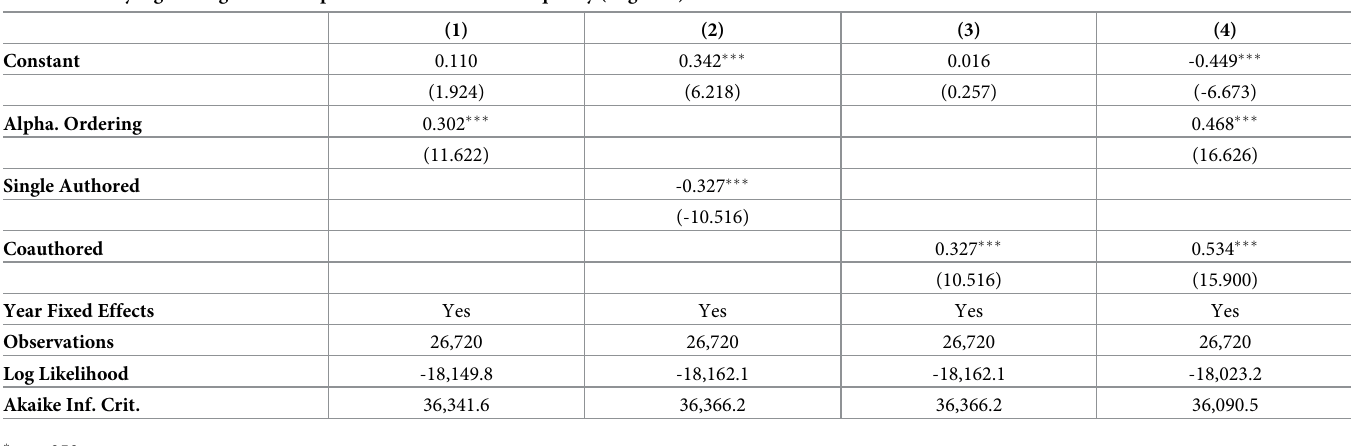
Table 5. Binary logistic regression: Dependent variable is article quality (High =